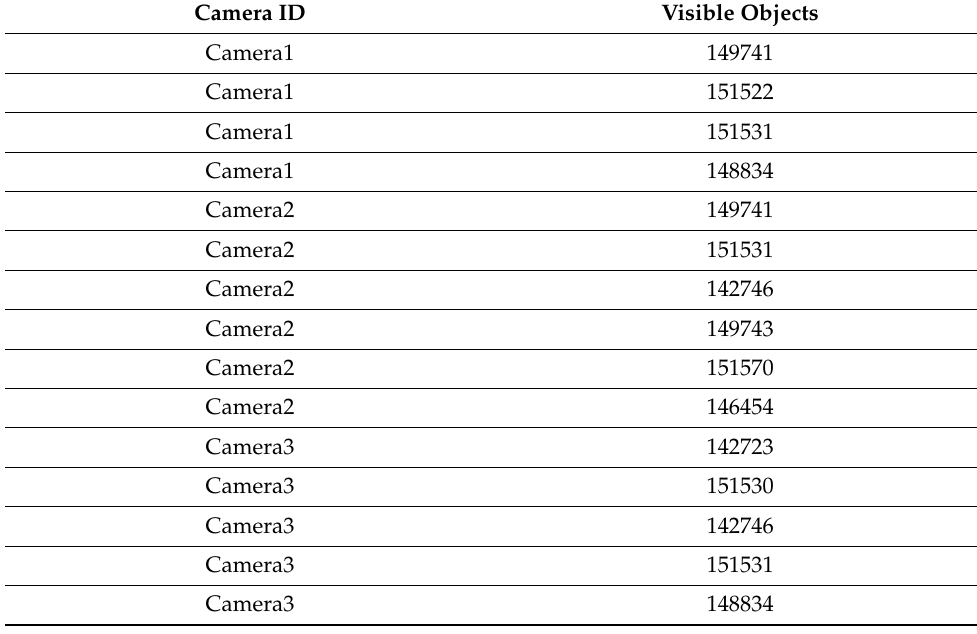
Table 5. Visibility index of CCTV and visible objects.